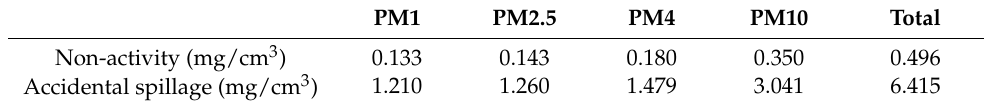
Table 5. Concentrations of PM10, PM4, PM2.5 and PM1 during the activity and non-activity periods. PM1 PM2.5 PM10 Total Non-activity (mg/cm 3 )